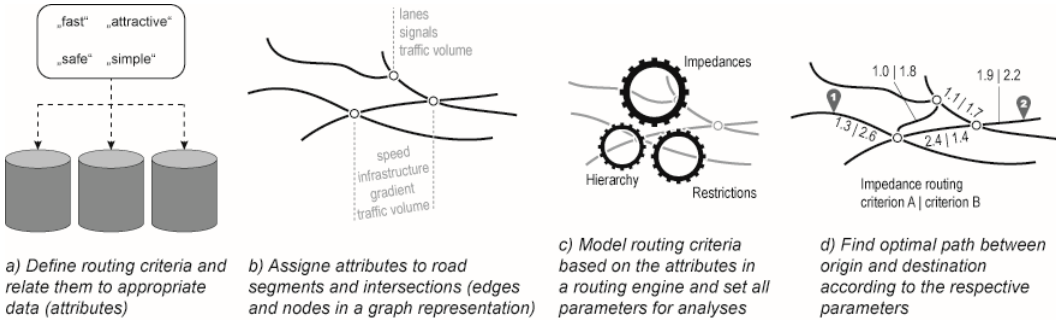
Figure 1. Workflow for the representation and processing of routing criteria. ( a ) Relate routing criteria to attributes; ( b ) assign attributes to road segments and intersections; ( c ) set parameters in a routing engine; ( d ) find optimal path.